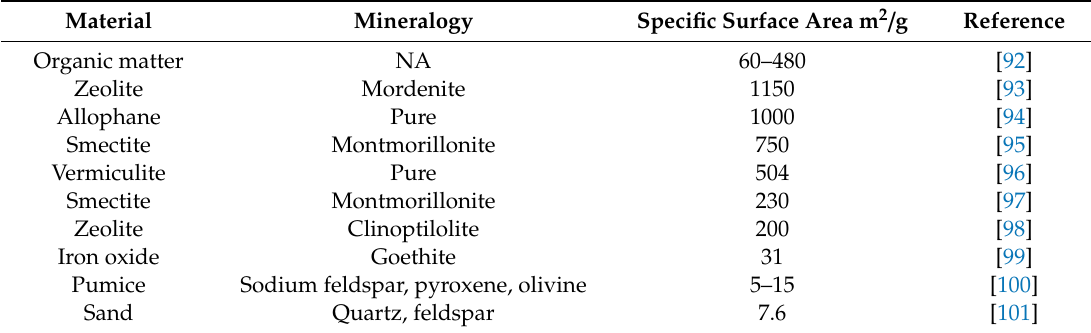
Table 2. Surface areas of a range of prospective materials for increasing soil moisture retention. Quartz (sand) is shown for a comparison against the high surface area materials.